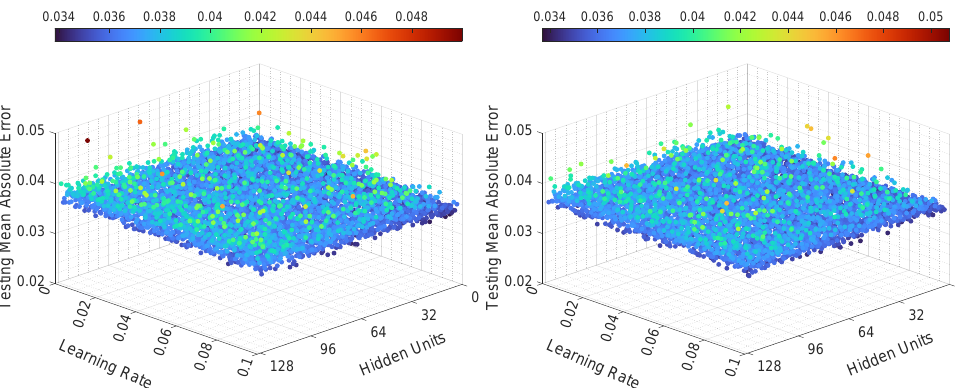
Figure 24. Illustration of the testing mean absolute error value for Experiment 3, LSTMTF ( left ), VLSTM ( middle ), and LSTMTFC ( right ), using a many-to-many prediction mode.